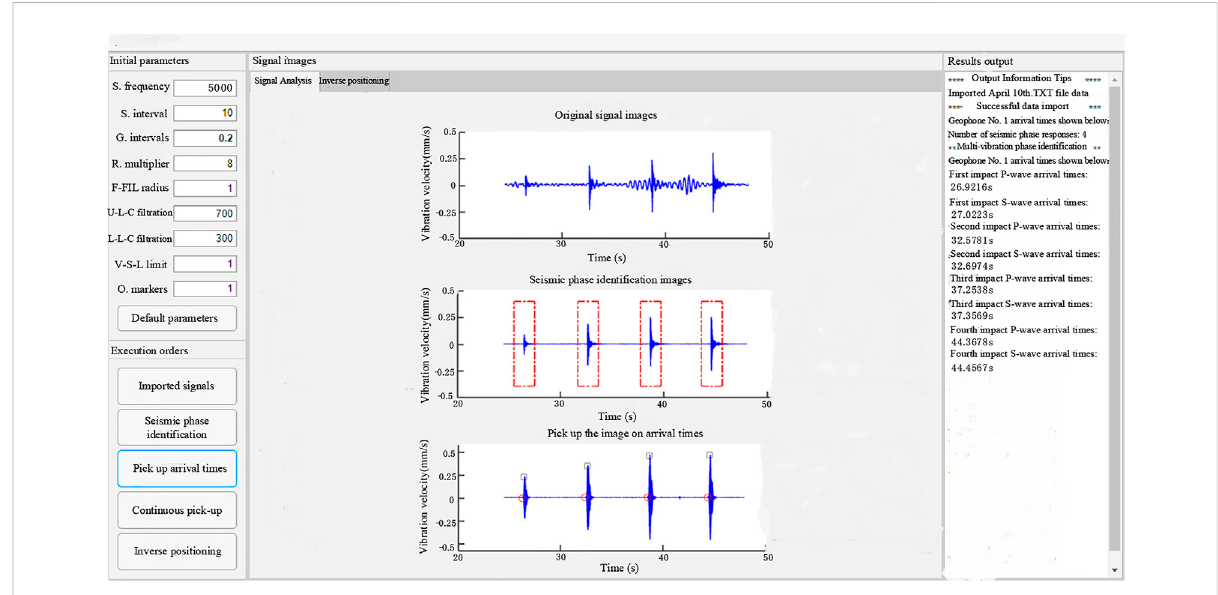
FIGURE 16 Software calculation of the April 10 microseismic arrival pickup event.